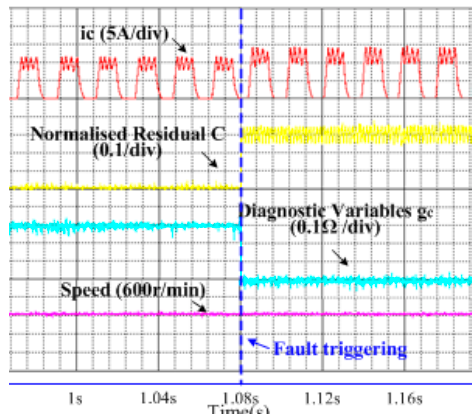
Figure 9. Experimental results for 30% turns of the motor winding faulty at low speed and no-load.